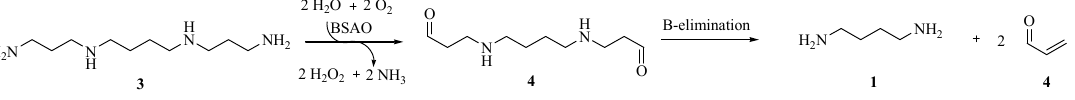
Figure 2. Chemical structures of BES ( N 1, N 12-diethyl spermine tetrahydrochloride) 5 and DENS-PM ( N 1, N 11-diethyl norspermine tetrahydrochloride) 6 .